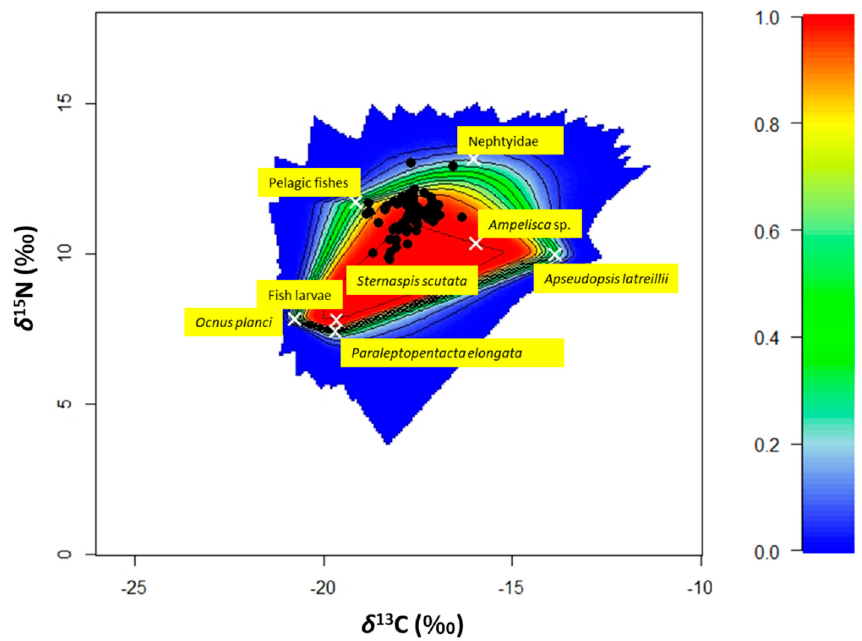
Figure 6. The biplot shows the simulated mixing with the positions of the specimens ( n = 68) of Solea solea (black dots) captured in the Central Adriatic Sea between January and December 2019 and the average signatures of the sources selected for determining the best mixing polygon (white crosses). Probability contours are at the 5% level (outermost contour) and at every 10% level, following the colours shown in the legend in the right part of the graph.